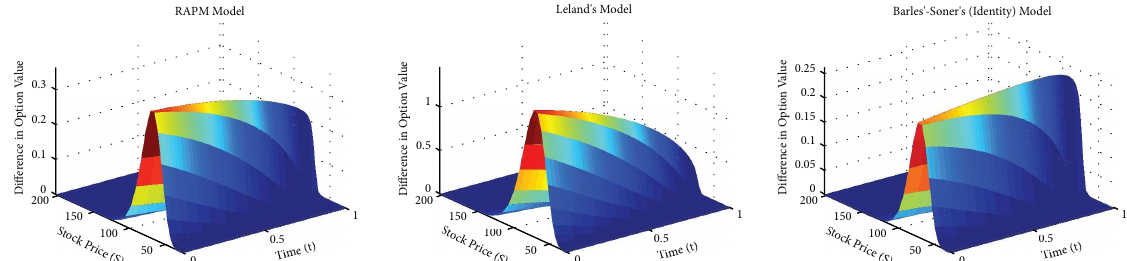
Figure 3: Here, we illustrate | V − V | considering the volatility models by the differential quadrature method, where NL stands for the NL L nonlinear model and L stands for the linear version of the same.